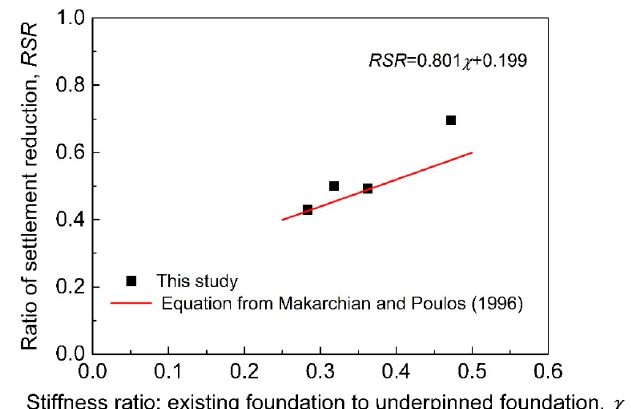
Figure 7. Relation between the reduction of foundation settlement by the underpinned foundation and the normalized stiffness of the existing foundation.